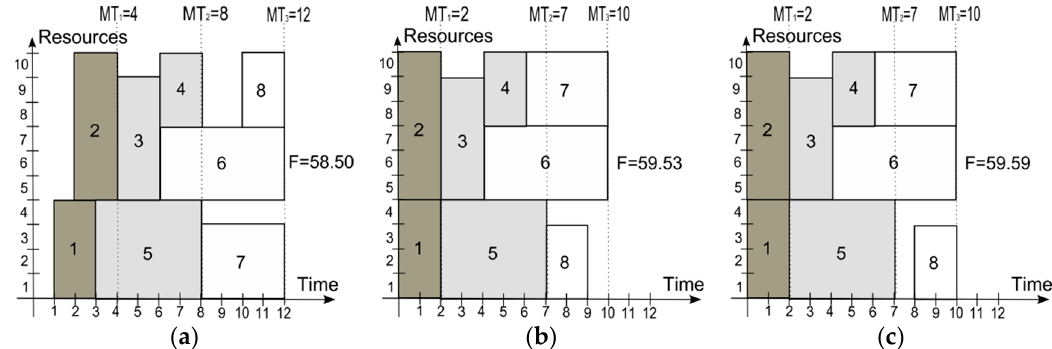
Figure 8. ( a ) Baseline schedule after right justification (RJ), ( b ) baseline schedule after RJ + left justification (LJ), ( c ) baseline schedule after RJ + LJ + RJ.